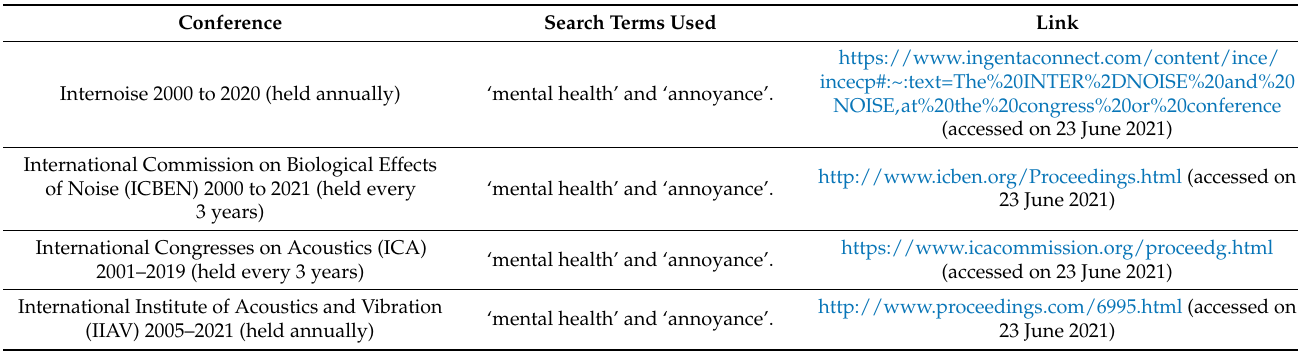
Table A1. List of conference proceedings.